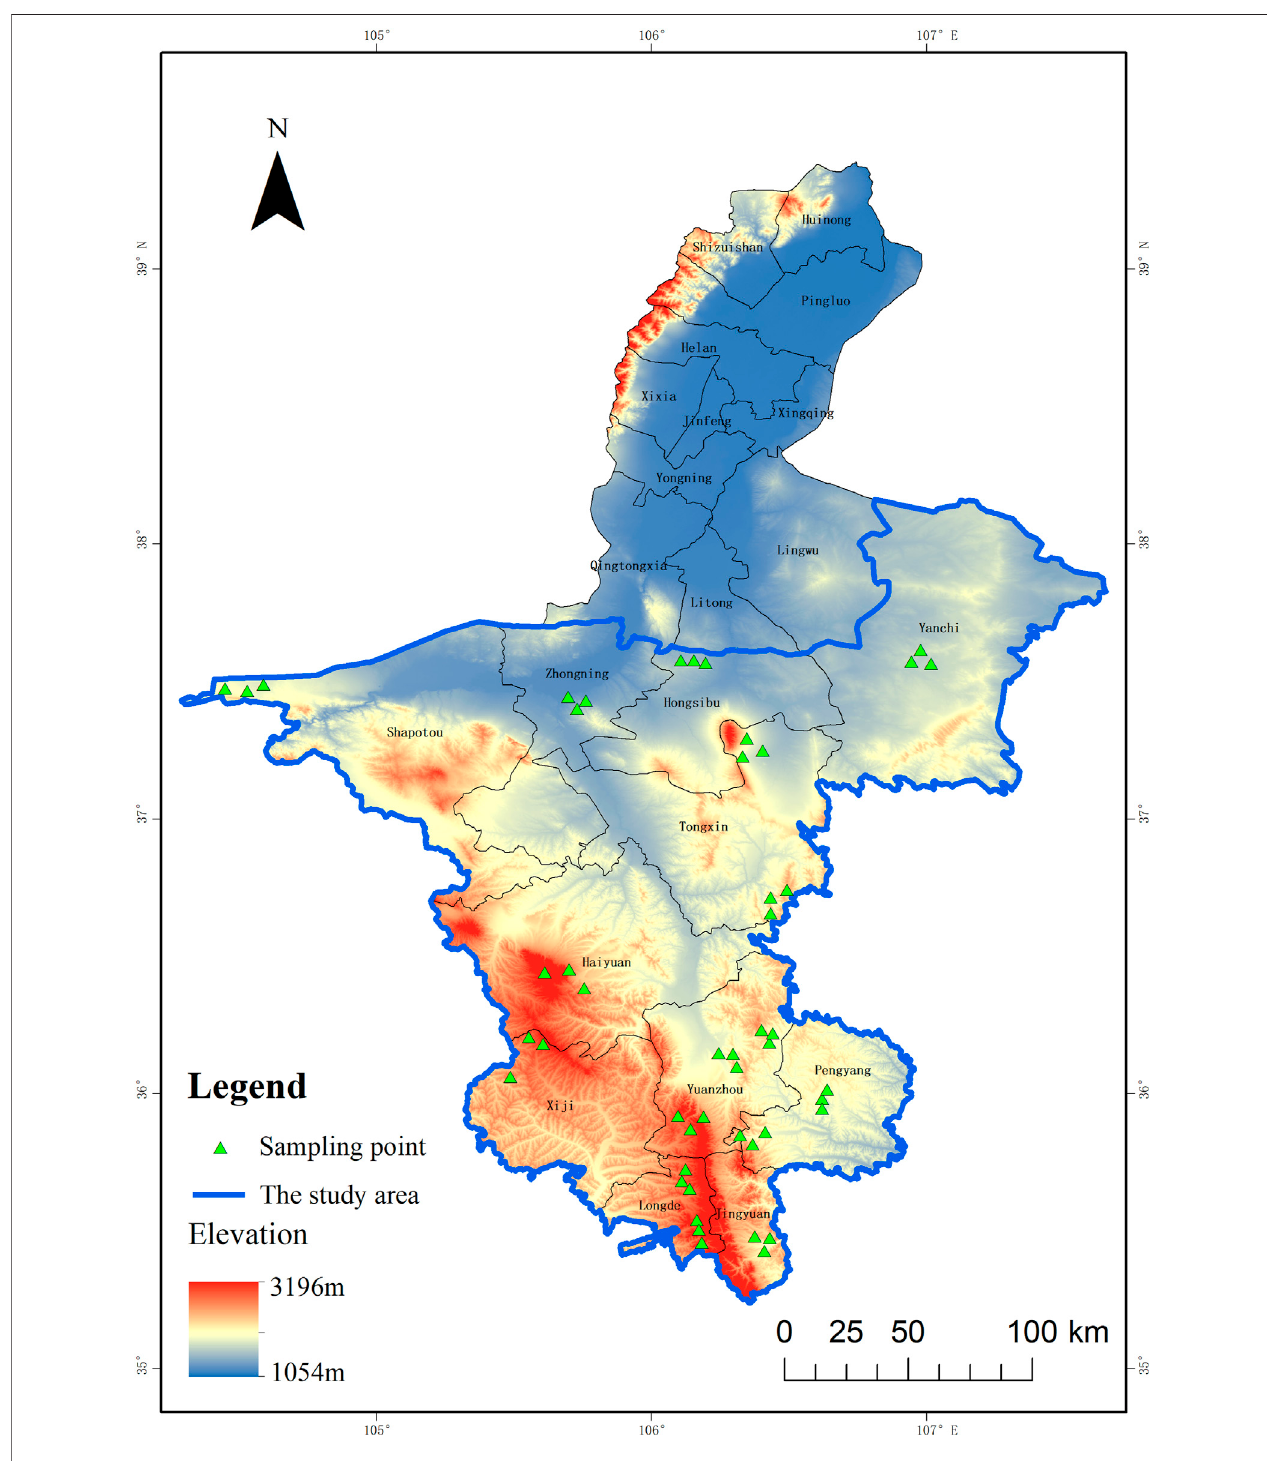
FIGURE 1 | Administrative region of Ningxia and the distribution of sampling points in the study area.